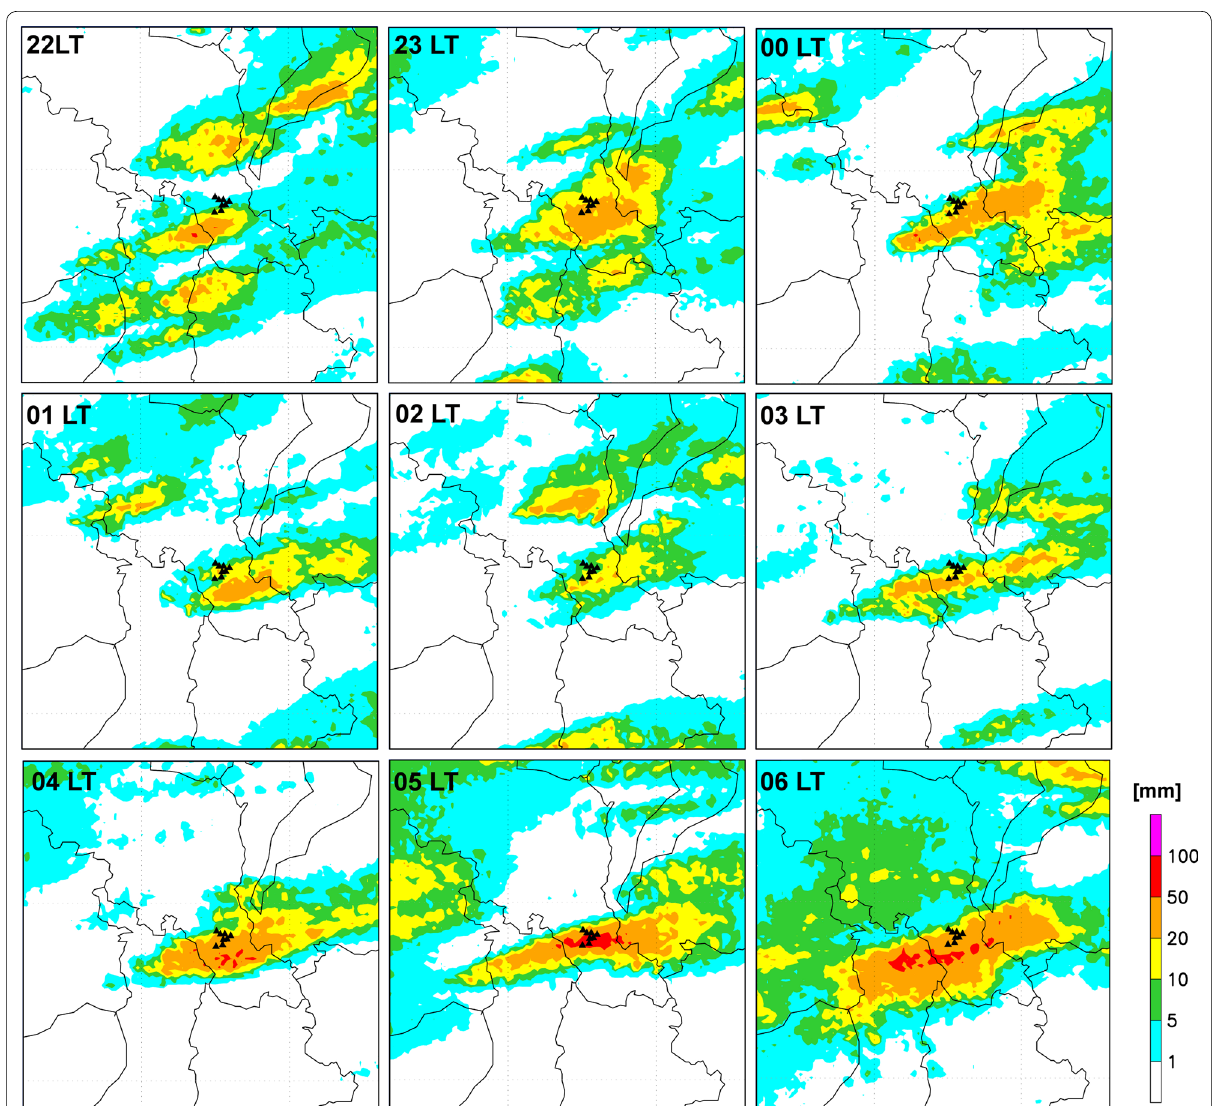
Fig. 2 Maps of hourly accumulated rainfall from 2200 LT on August 13, 2012, to 0600 LT on August 14, 2012, derived from radar data of JMA. Trian- gles indicate stations of the Uji